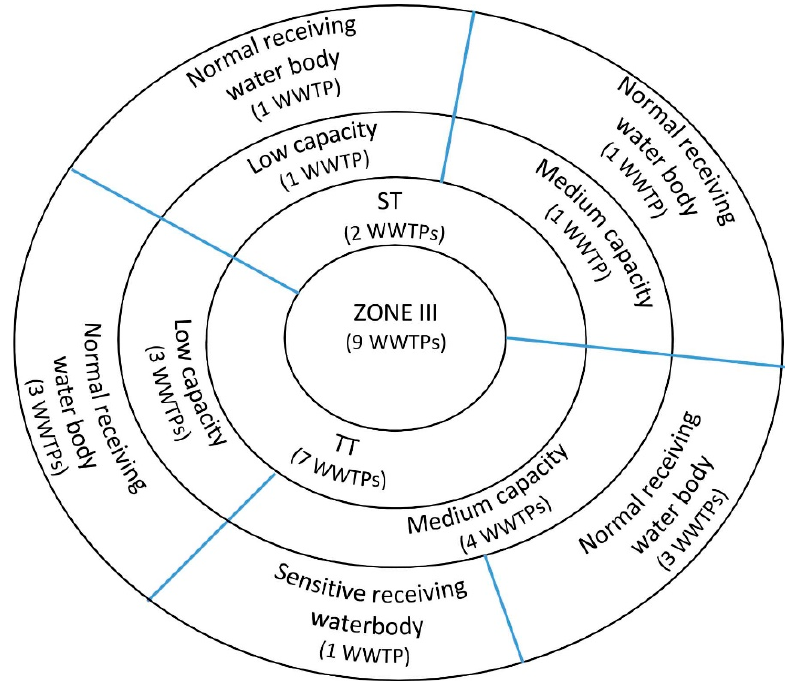
Figure 2. Categorization of WWTPs for Zone II of EHZ.